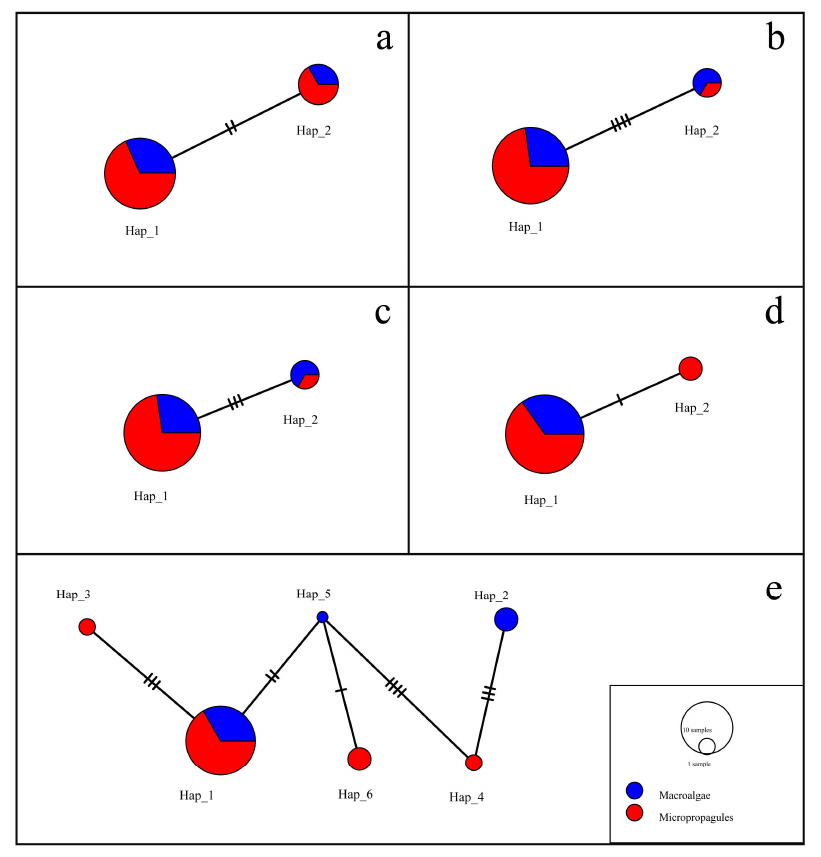
Figure 13. Network diagram for the U. aragoensis haplotypes derived from the 18S ( a ), internal transcribed spacers ( b ), large subunit ( c ), rps2- trn L ( d ), and 18S-internal transcribed spacers-large subunit-rps2- trn L ( e ) gene sequences. The circle symbol represents one haplotype, and its size reflects the number of different haplotypes. Different colors represent different sources, from which the haplotypes were derived, and blank circles indicate undetected haplotypes.